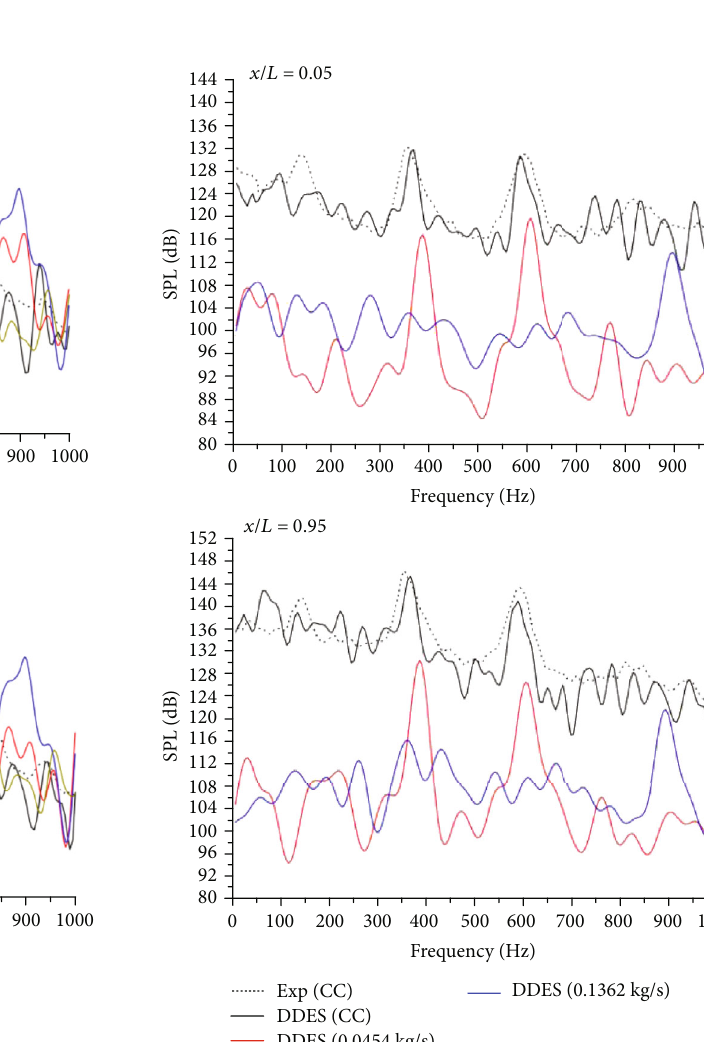
Figure 5: Sound pressure level at x / L = 0 : 05 and 0.95.